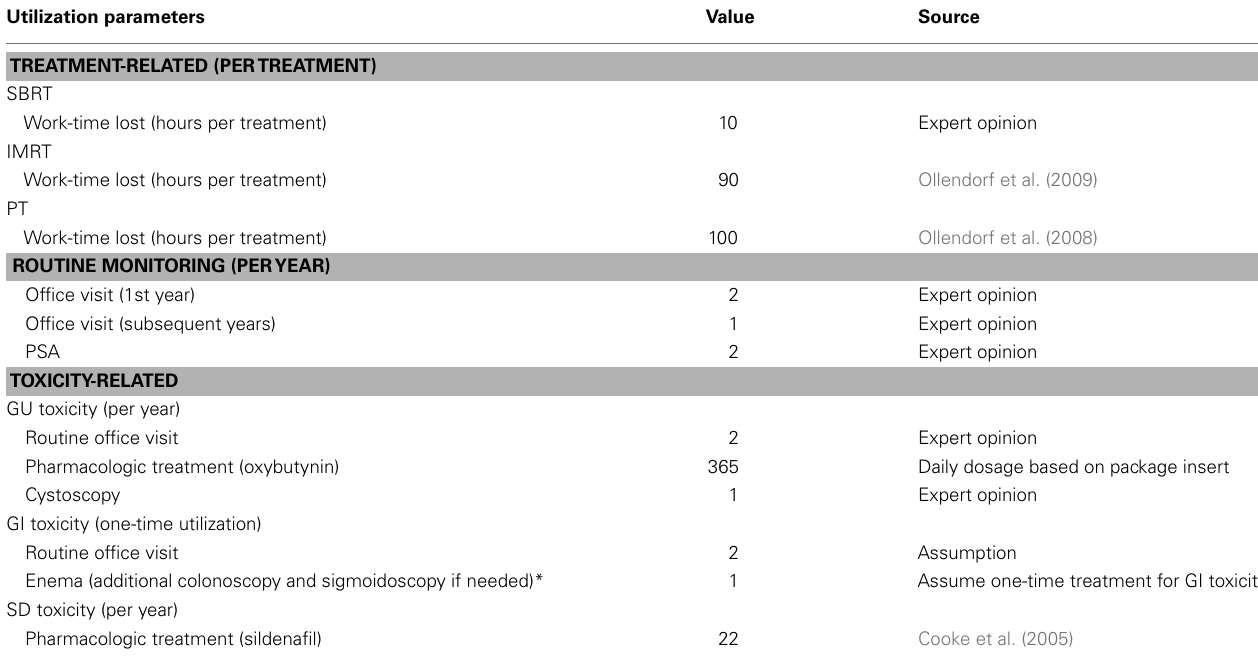
Table 4 | Model resource utilization